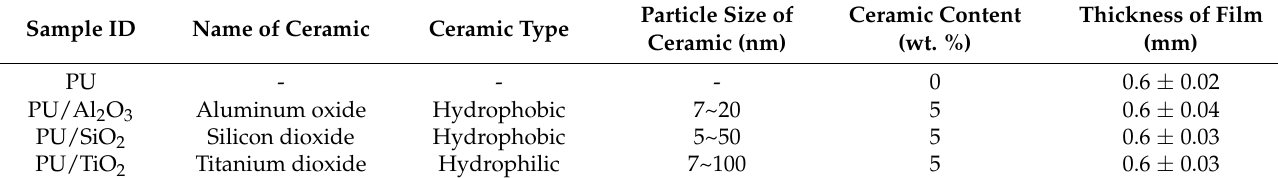
Table 1. Compositions and characteristics of the samples.